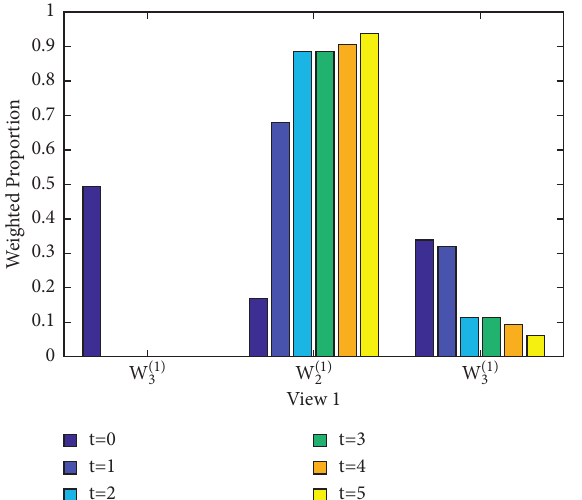
Figure 6: Comparison of prediction results of training samples.